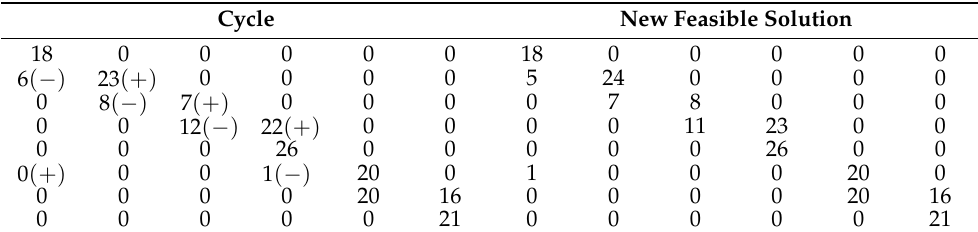
Table 12. Cycle design and new feasible solution.